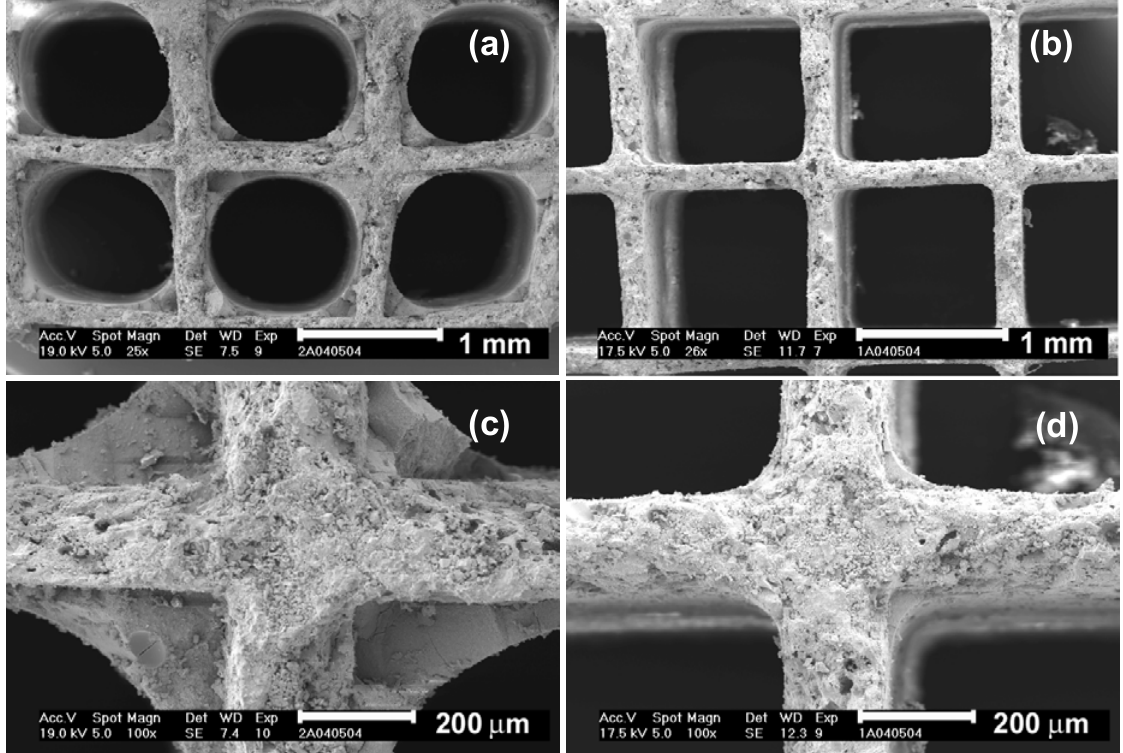
Figure 4. SEM pictures of the channels (cross section) from α -Al after the first [(b) and (d)] and the last [(a) and (c)] coating. From reference [17], with permission from